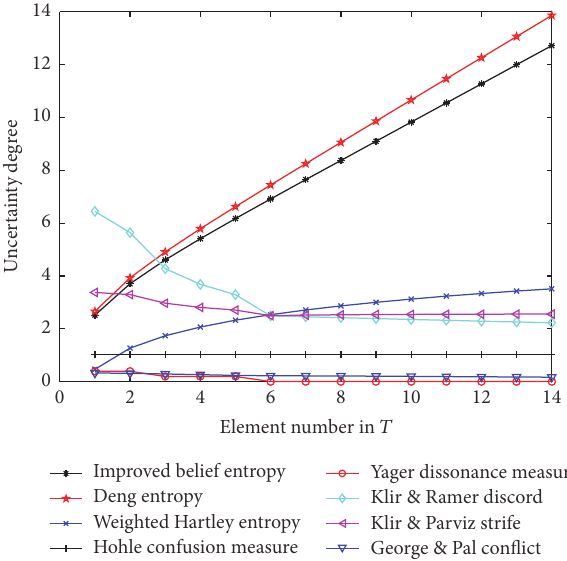
Figure 1: Comparison among different uncertainty